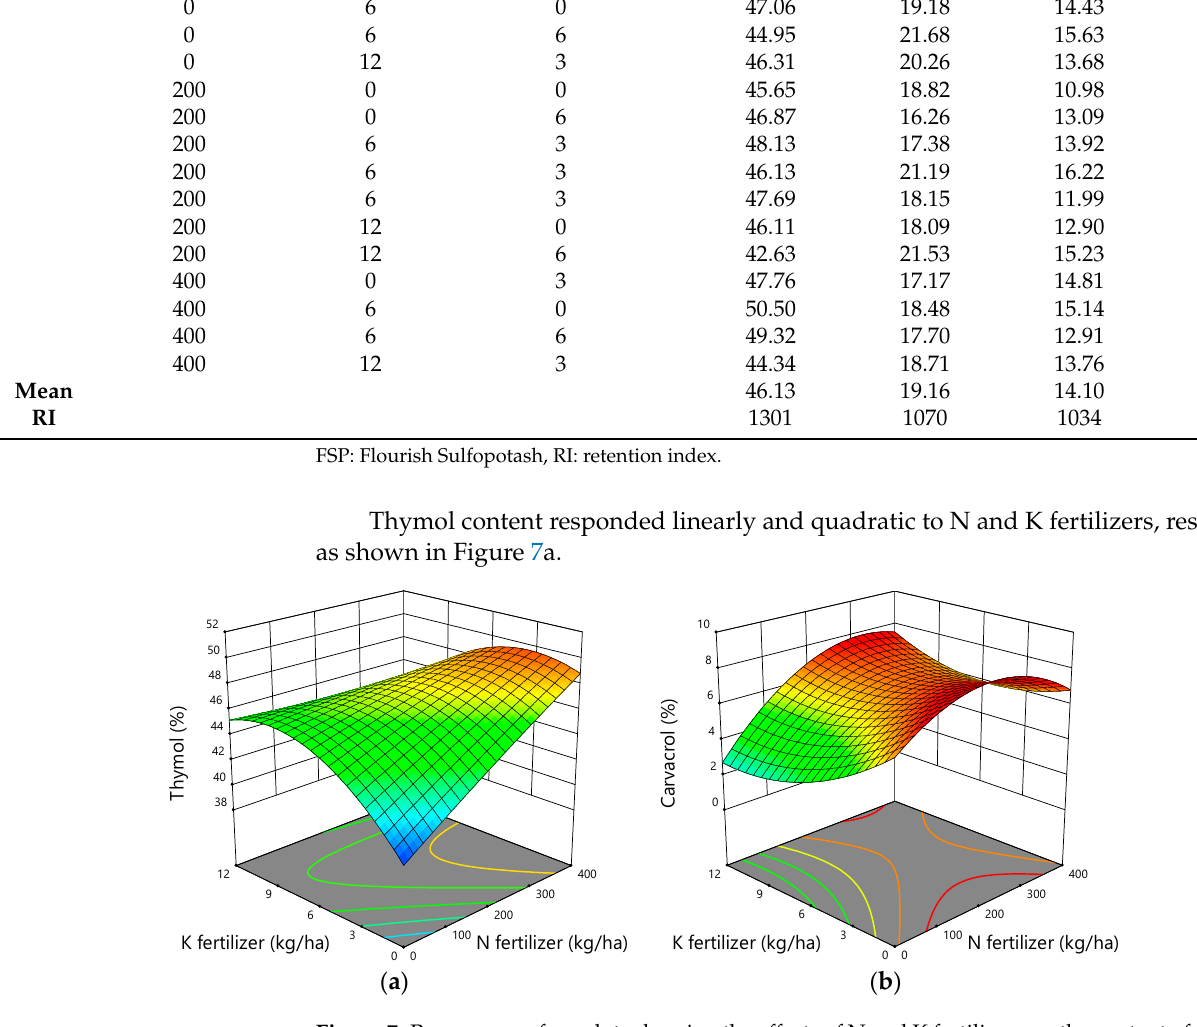
Figure 7. Response surface plots showing the effects of N and K fertilizers on the content of thymol ( a ), and carvacrol ( b ). The seaweed extract was kept constant at 3 L ha − 1 .